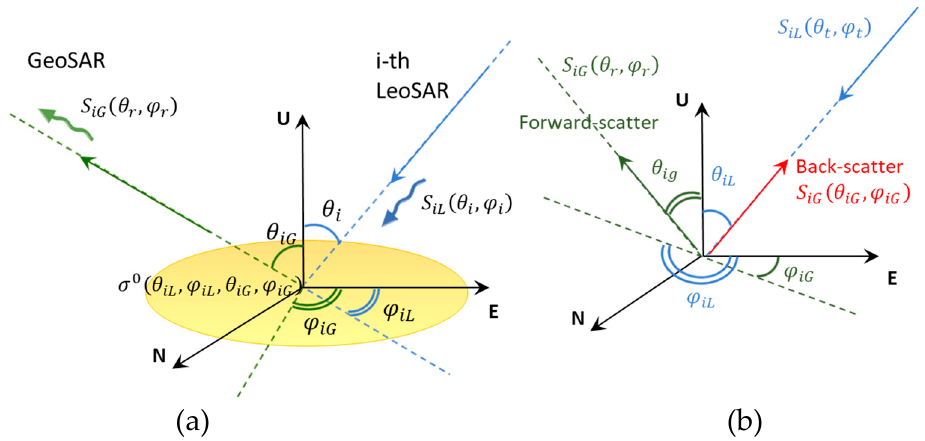
Figure 3. Models for the bistatic backscatter from the i -th LEO-SAR to the GEO-SAR. ( a ) Geometry, as seen from the target position: Notice the change of backscatter plane between LEO and GEO directions. ( b ) Cases of forward and back-scattering. S iL and S iG represent the incoming signal from LEO-SAR and outgoing to the GEO-SAR.